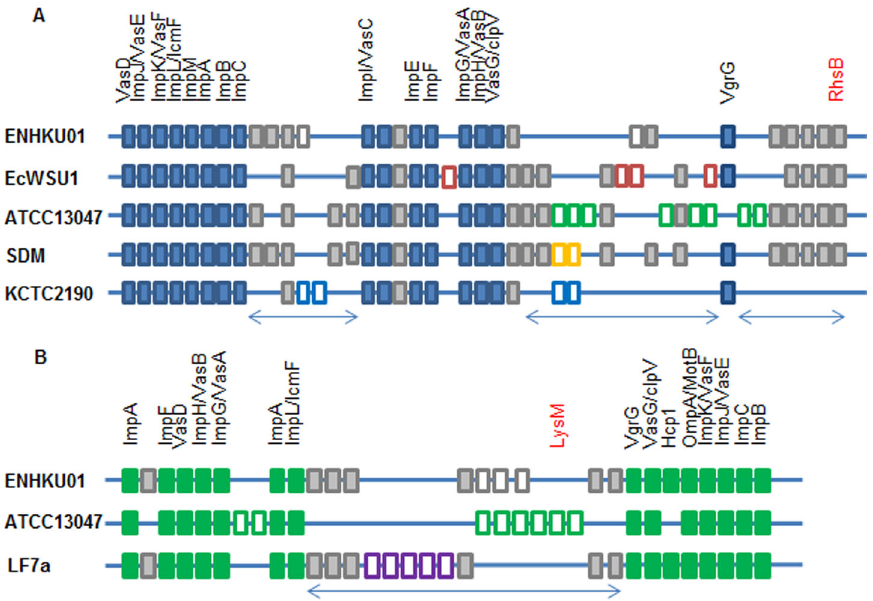
Figure 6. Genetic organization of T6SS in Enterobacter . (A) and (B) show genetic organization of the two T6SS clusters commonly found in Enterobacter . ENHKU01 and ATCC13047 contain both T6SS, and EcWSU1, SDM and LF7a have one of the two, and other Enterobacter have none. The two clusters of T6SS in Enterobacter have different genetic organization but are aligned across the Enterobacter genomes at the corresponding loci. Each T6SS cluster is composed of conserved regions formed by conserved T6SS core component genes, which are indicated in solid blue/ green color boxes, and variable regions that are indicated by arrows. The variable regions contain a variable number of conserved genes (solid gray color) and unique genes (white color boxes). Most genes located in the variable regions are described as hypothetical proteins. Genes possibly involved in bacteriocin activity are shown in red. Details of the genetic organization of T6SSs in Enterobacter are listed in Data S4. doi: